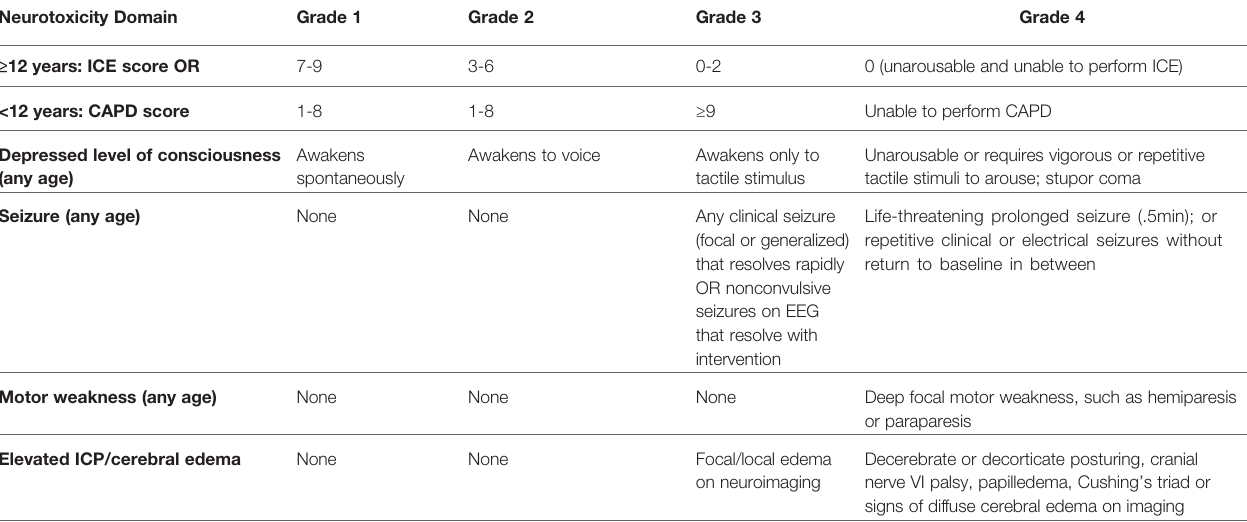
TABLE 6 | ICANS grading and